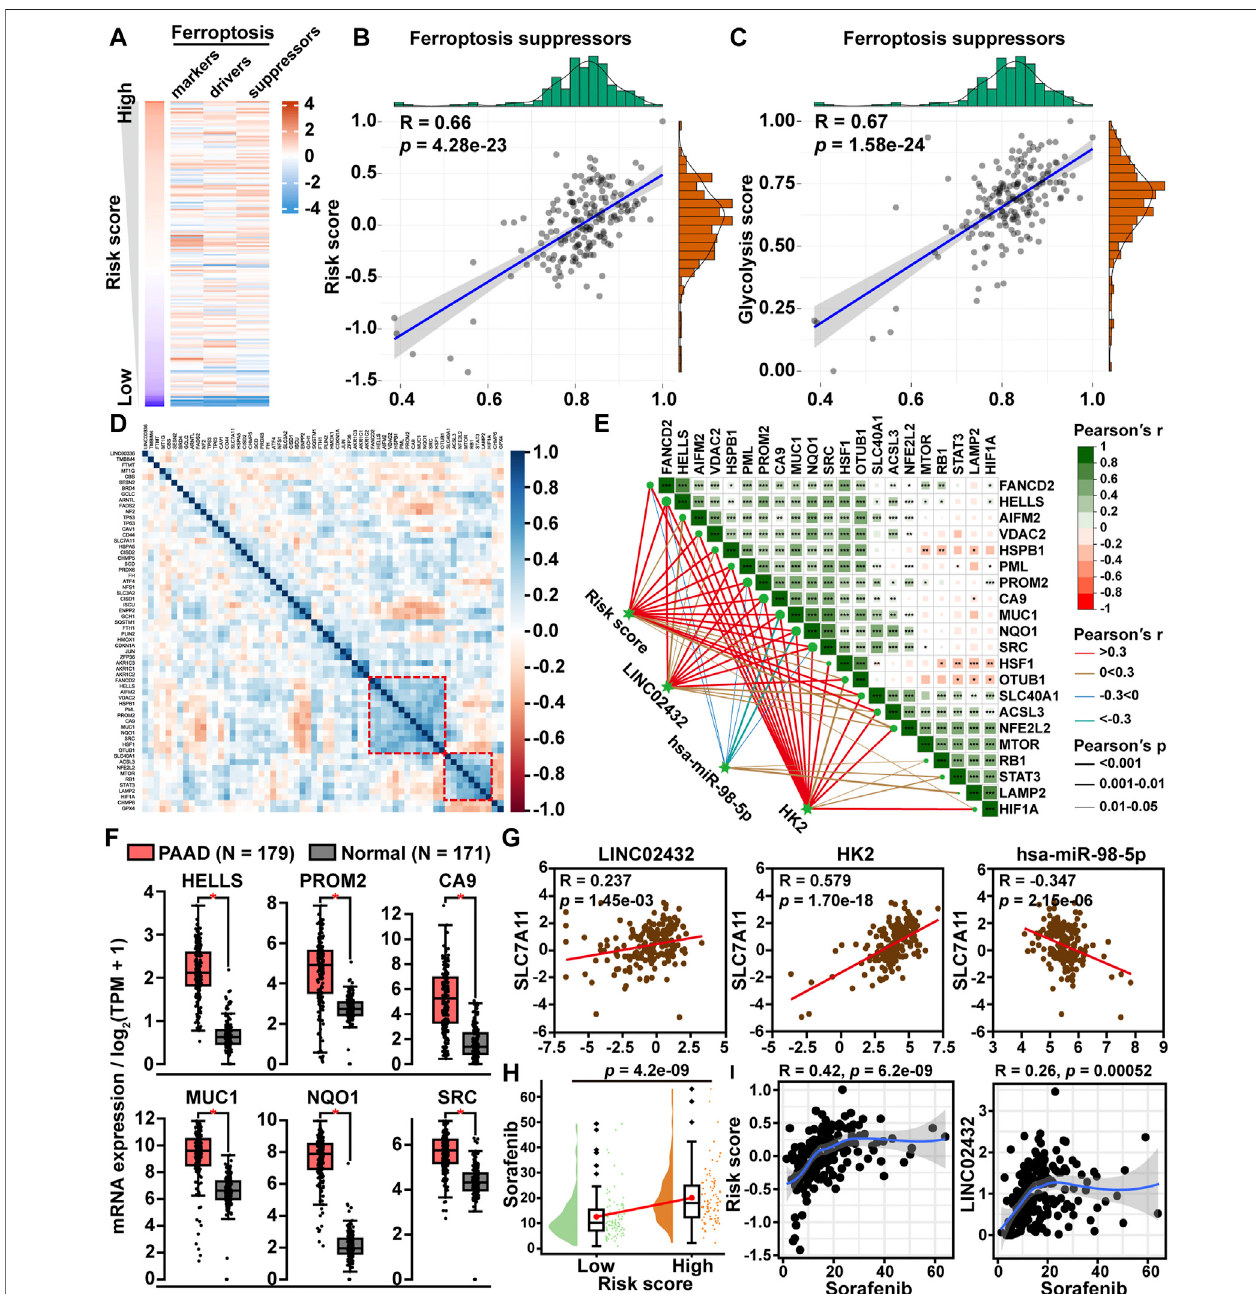
FIGURE4| ThecorrelationbetweenLINC02432/hsa-miR-98 – 5p/HK2axisandferroptosis. (A) HeatmapofssGSEAscoresforthethreeferroptosis-relatedgenes in PAAD samples. (B) Dot plot of Pearson correlation between ceRNA risk score and ferroptosis suppressor gene set score. (C) The Pearson correlation was used to assess the relationship between glycolysis score and ferroptosis suppressor gene set score. (D) Correlation heatmap showing the clustering of ferroptosis suppressor gene expression. (E) The correlation heatmap demonstrated the relationship between the LINC02432/hsa-miR-98 – 5p/HK2 axis and two ferroptosis suppressor gene clusters. (F) GEPIA data analysis exhibited the differential expression of HELLS, PROM2, CA9, MUC1, NQO1, and SRC in PAAD compared to normal tissue. (G) Pearson correlation analysis was applied to assess the relationship between SLC7A11 and LINC02432/hsa-miR-98 – 5p/HK2 axis. (H) Comparison of sorafenib IC50 between low and high risk score groups in PAAD. (I) Correlation between LINC02432 expression and sorafenib IC50 values.